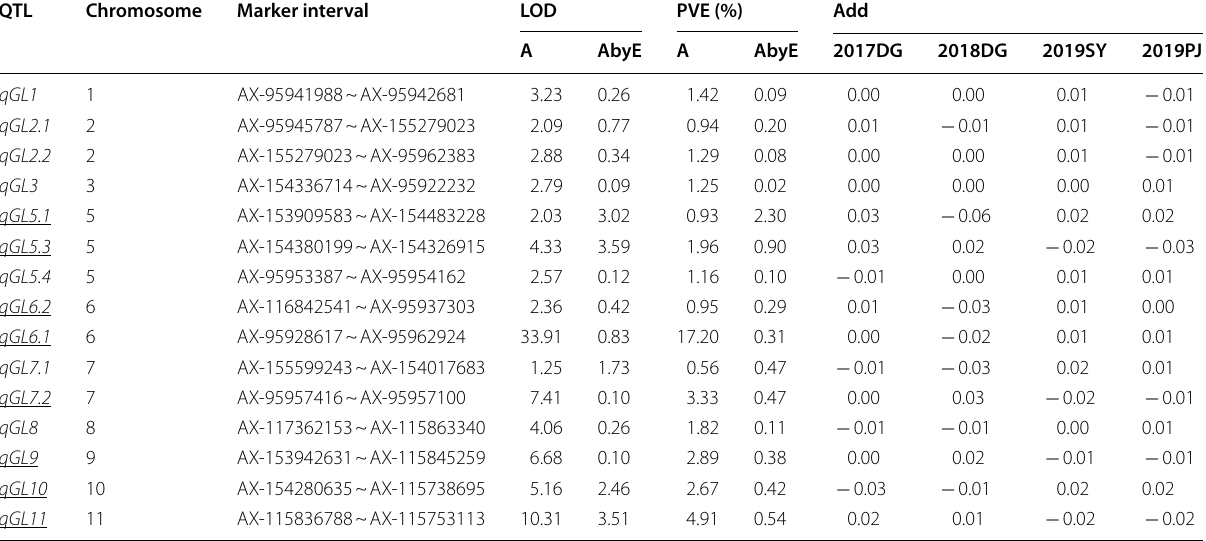
The underline represented that these QTLs were also detected in individual environment analyses